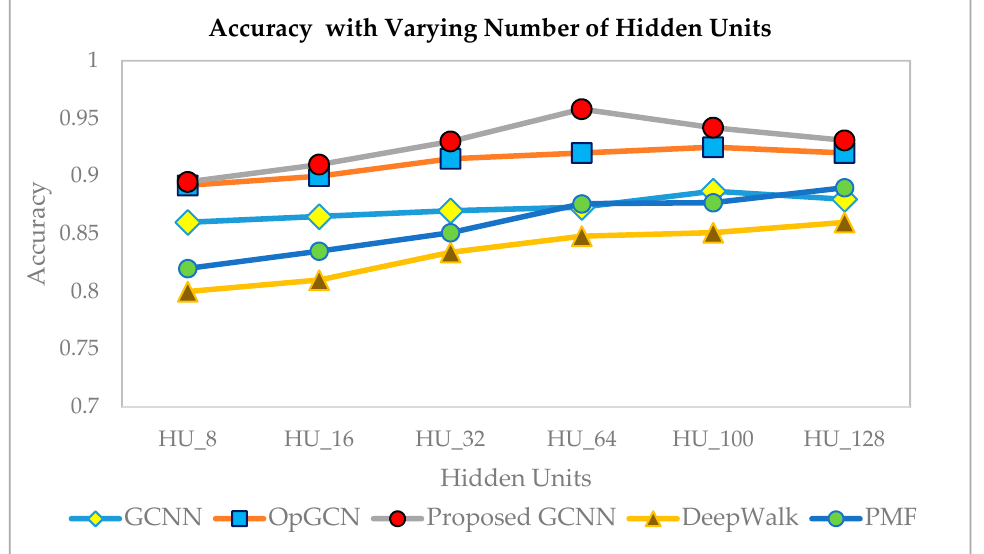
Figure 9. Testing accuracy against hidden units.